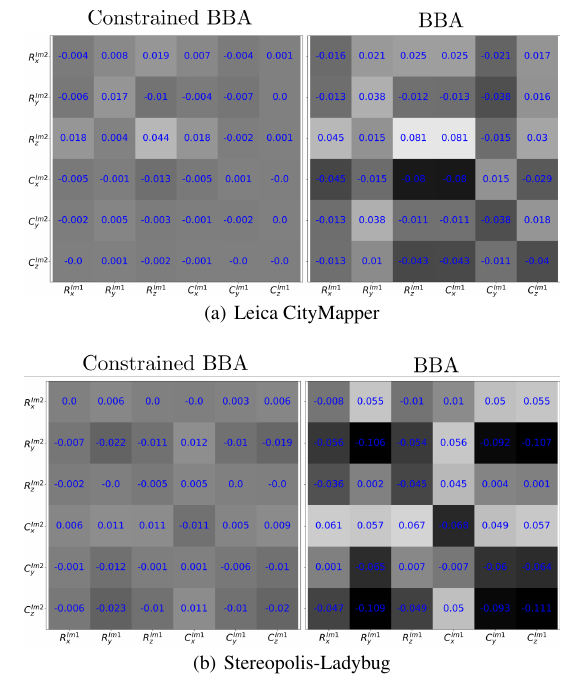
Figure 8. Correlation matrices between two sample images in (a) Leica CityMapper and (b) Stereopolis-Ladybug datasets. In each 6x6 matrix, the first three elements denoted as R x , R y , R z correspond to the rotations, whereas the latter C x , C y , C z correspond to the perspective center. The left column presents the result of the constrained BBA, and the right column is the BBA without